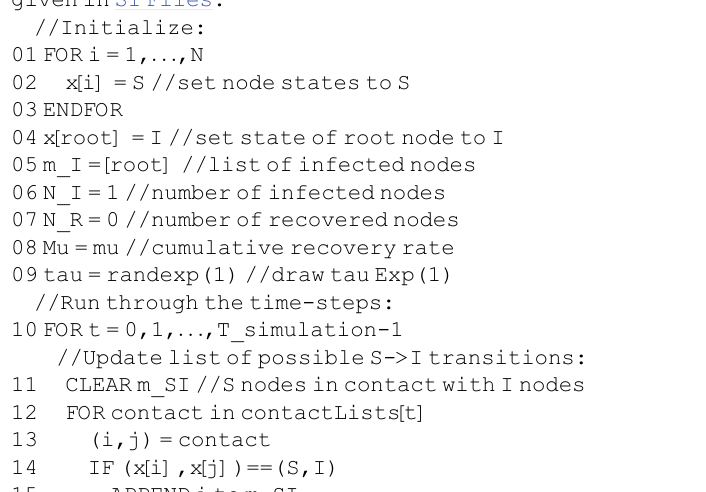
Pseudocode 1: Pseudocode for an SIR process with constant and homogeneous transition rates. C++ code for homogeneous and heterogeneous populations is given in S1